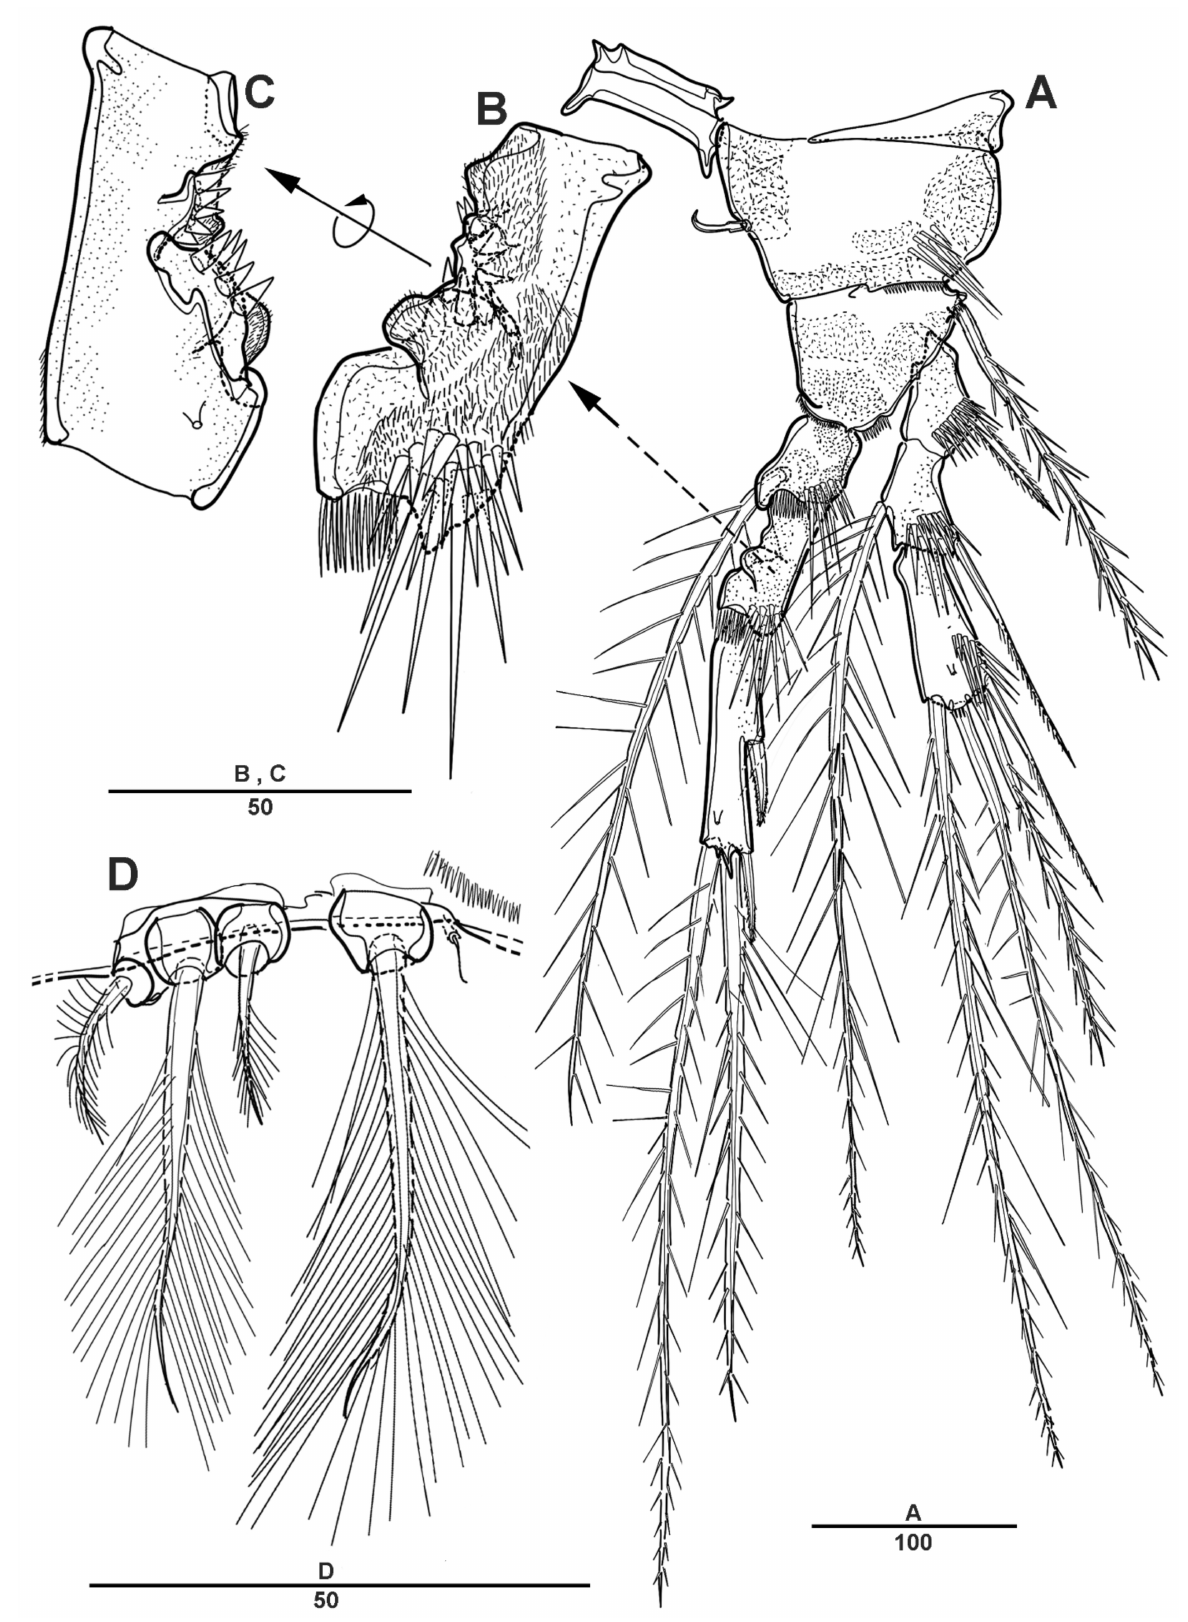
Figure 10. Scottolana daecheonensis sp. nov. paratype male: ( A ) P4, anterior; ( B ) P4 enp-2, anterior; ( C ) P4 enp-2, posterior; ( D ) P5. Scale bars in µ